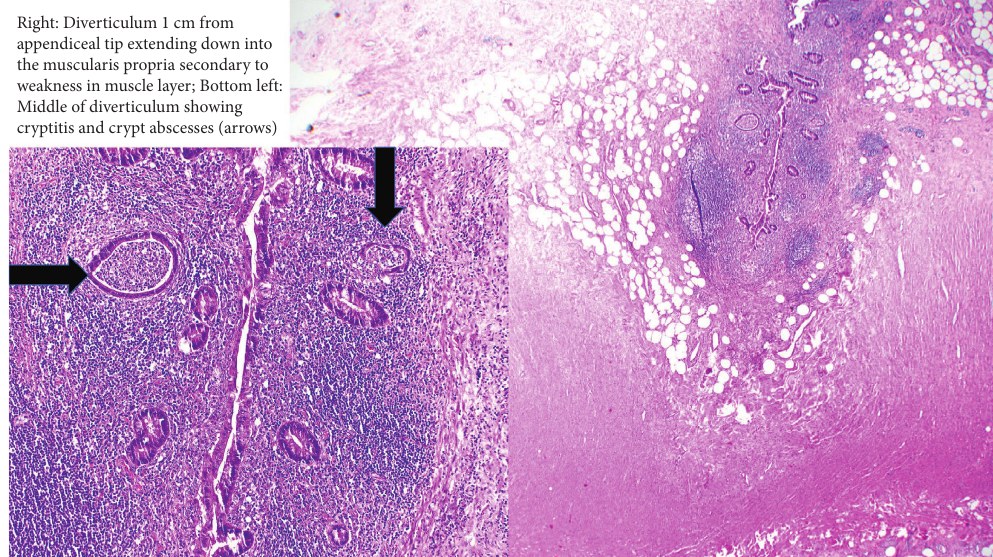
Figure 3: Histopathology of appendiceal diverticulitis in the portion of the remaining viable